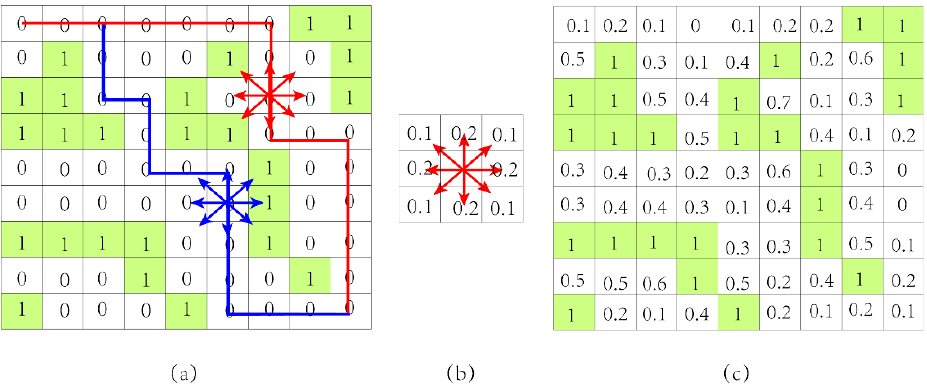
Figure 12. Conversion of the binary digital map to map with the dangerous potential field: ( a ) a valid binary map with several collision-free paths, ( b ) effect weights of the dangerous potential field to the center grid, ( c ) map with the dangerous potential field.